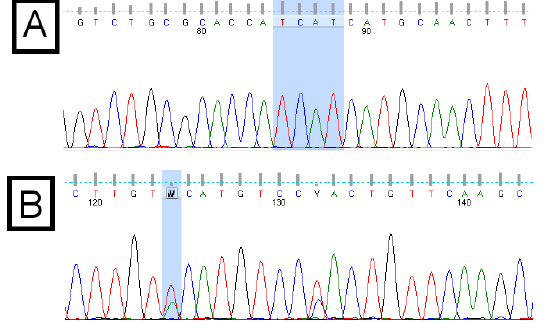
Figure 1. Example chromatograms of the basic core promotor/precore (BCP/PC) region of the hepatitis B virus (HBV) genome. Panel ( A ) shows the “Kozak” region (TCAT) of subgenotype A1, followed by the “ATG” pre-core start codon; Panel ( B ) shows